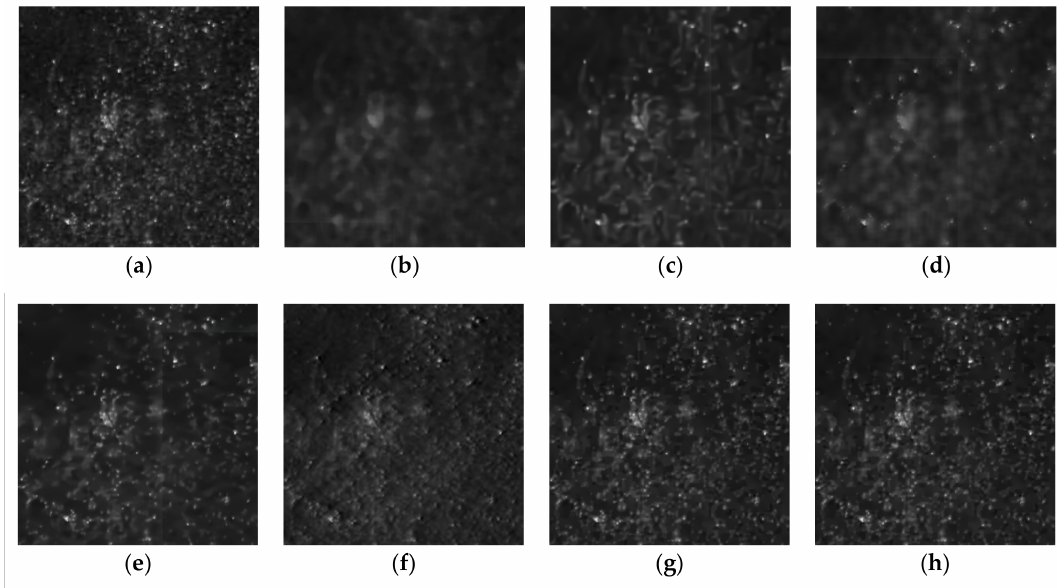
Figure 13. The restoration of gray value of PSi microcavity with an incident angle of 5 ◦ . ( a ) Original image; ( b ) adaptive median filter; ( c ) BM3D; ( d ) Lee; ( e ) PNLM; ( f ) NAWT; ( g ) PM; ( h )